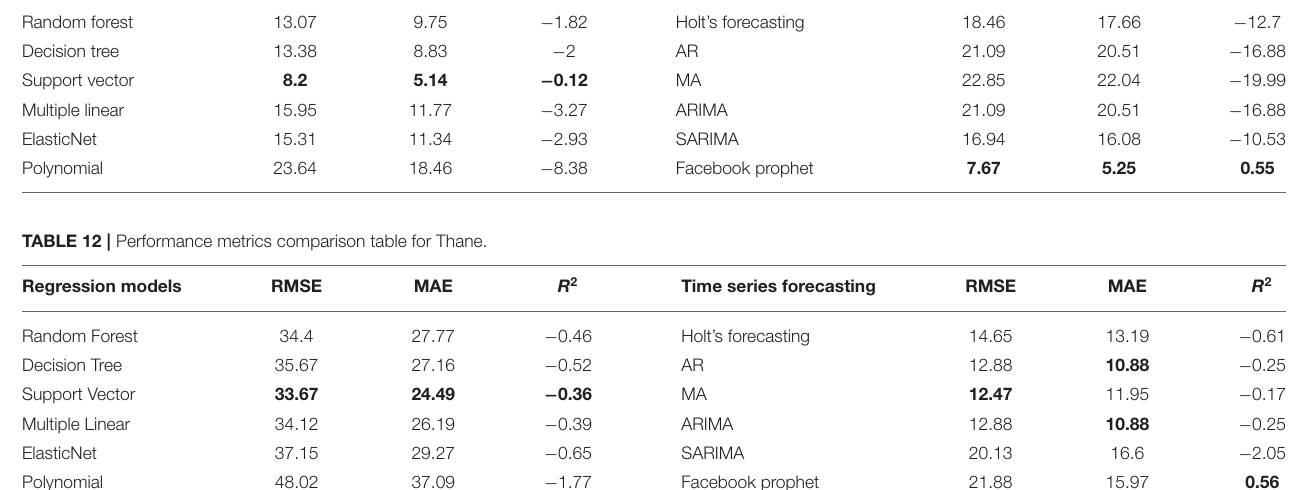
TABLE 11 | Performance metrics comparison table for Solapur. Regression models